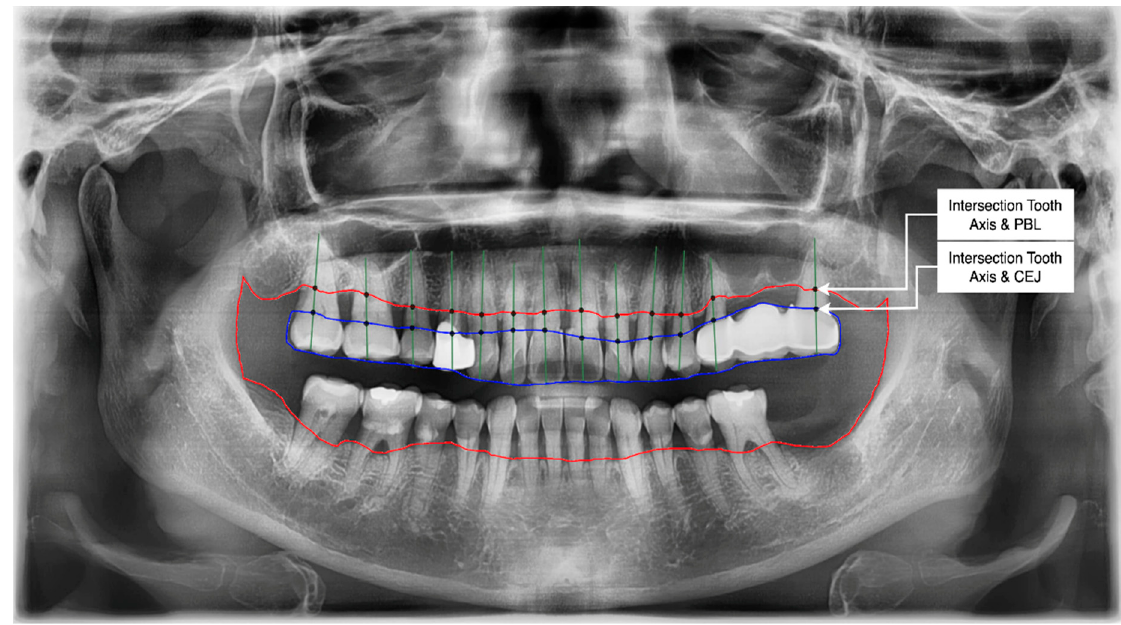
Figure 10. PBL and CEJ intersection with the tooth main axis.